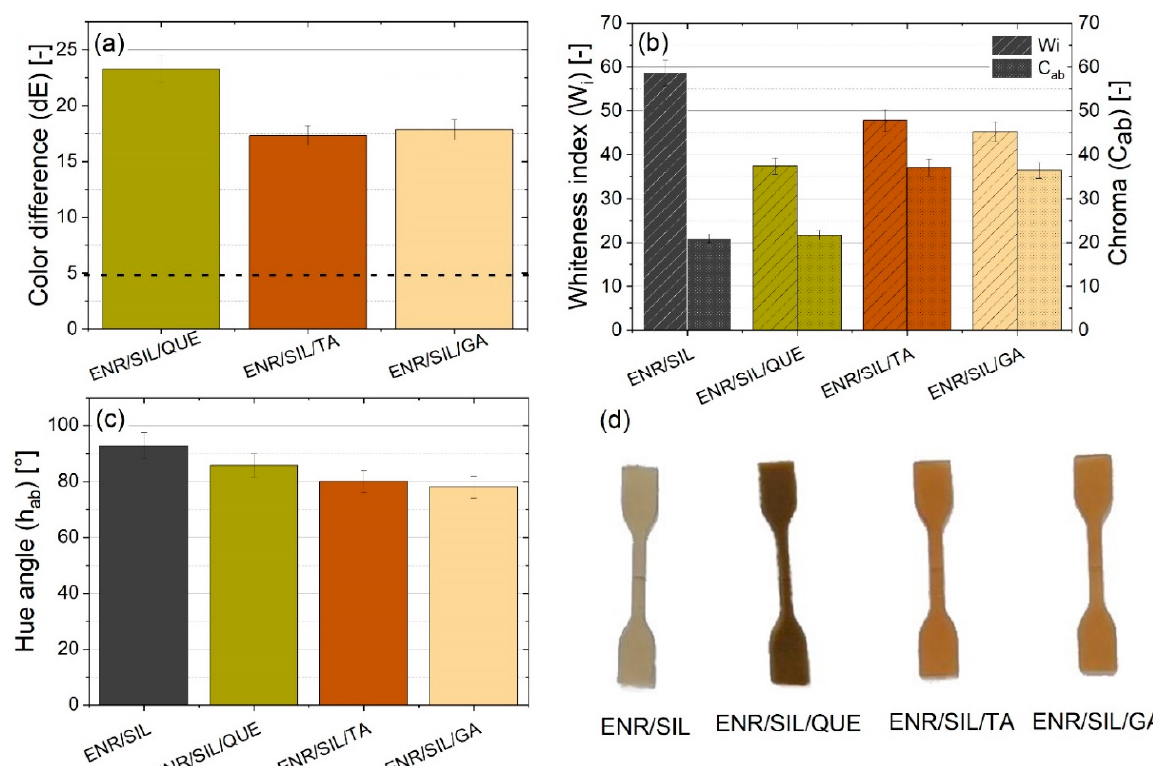
Figure 6. The color difference between ENR/SIL composite and ENR/SIL material with natural phenolic compounds addition ( a ), whiteness index and chroma ( b ), hue angle ( c ), and photos of ENR/silica-based samples ( d ).